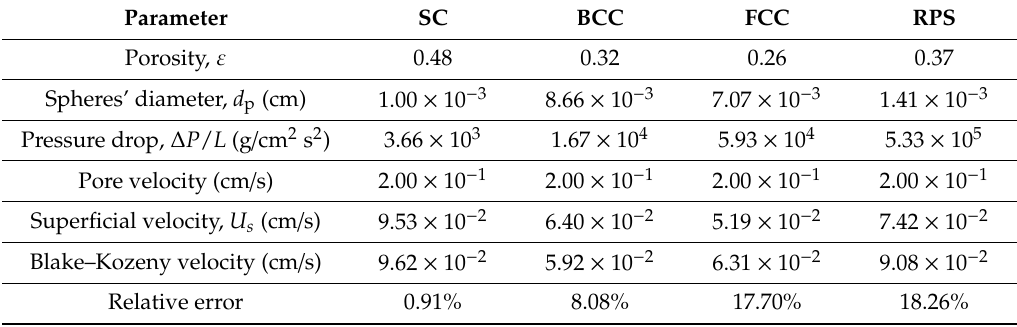
Table 3. The lattice Boltzmann method (LBM) code verification by Blake–Kozeny equation. The reported error is the relative absolute error for the calculated superficial